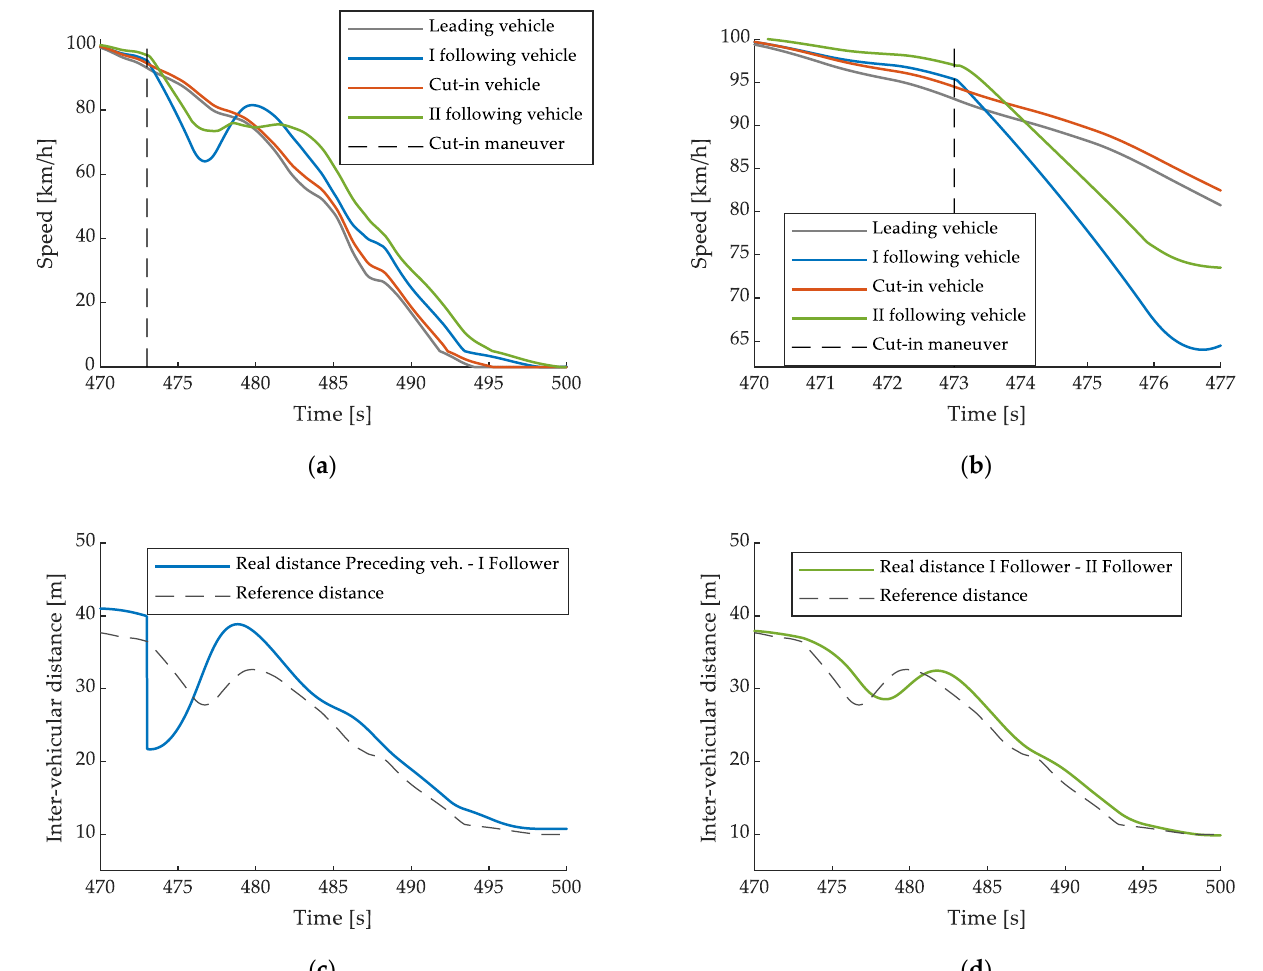
Figure 4. Safety analyses on the aggressive deceleration phase of the US06 drive mission: ( a ) speed traces of the four vehicles (i.e., the three vehicles platooning and the fourth cutting in vehicle (in red)), ( b ) zoomed time window of the four vehicles speed profiles, ( c ) actual and reference inter-vehicular distances between the I follower and its preceding vehicle (i.e., the leader until the cut-in maneuver occurs and then the cut-in vehicle), and ( d ) actual and reference inter-vehicular distances between II and I followers.